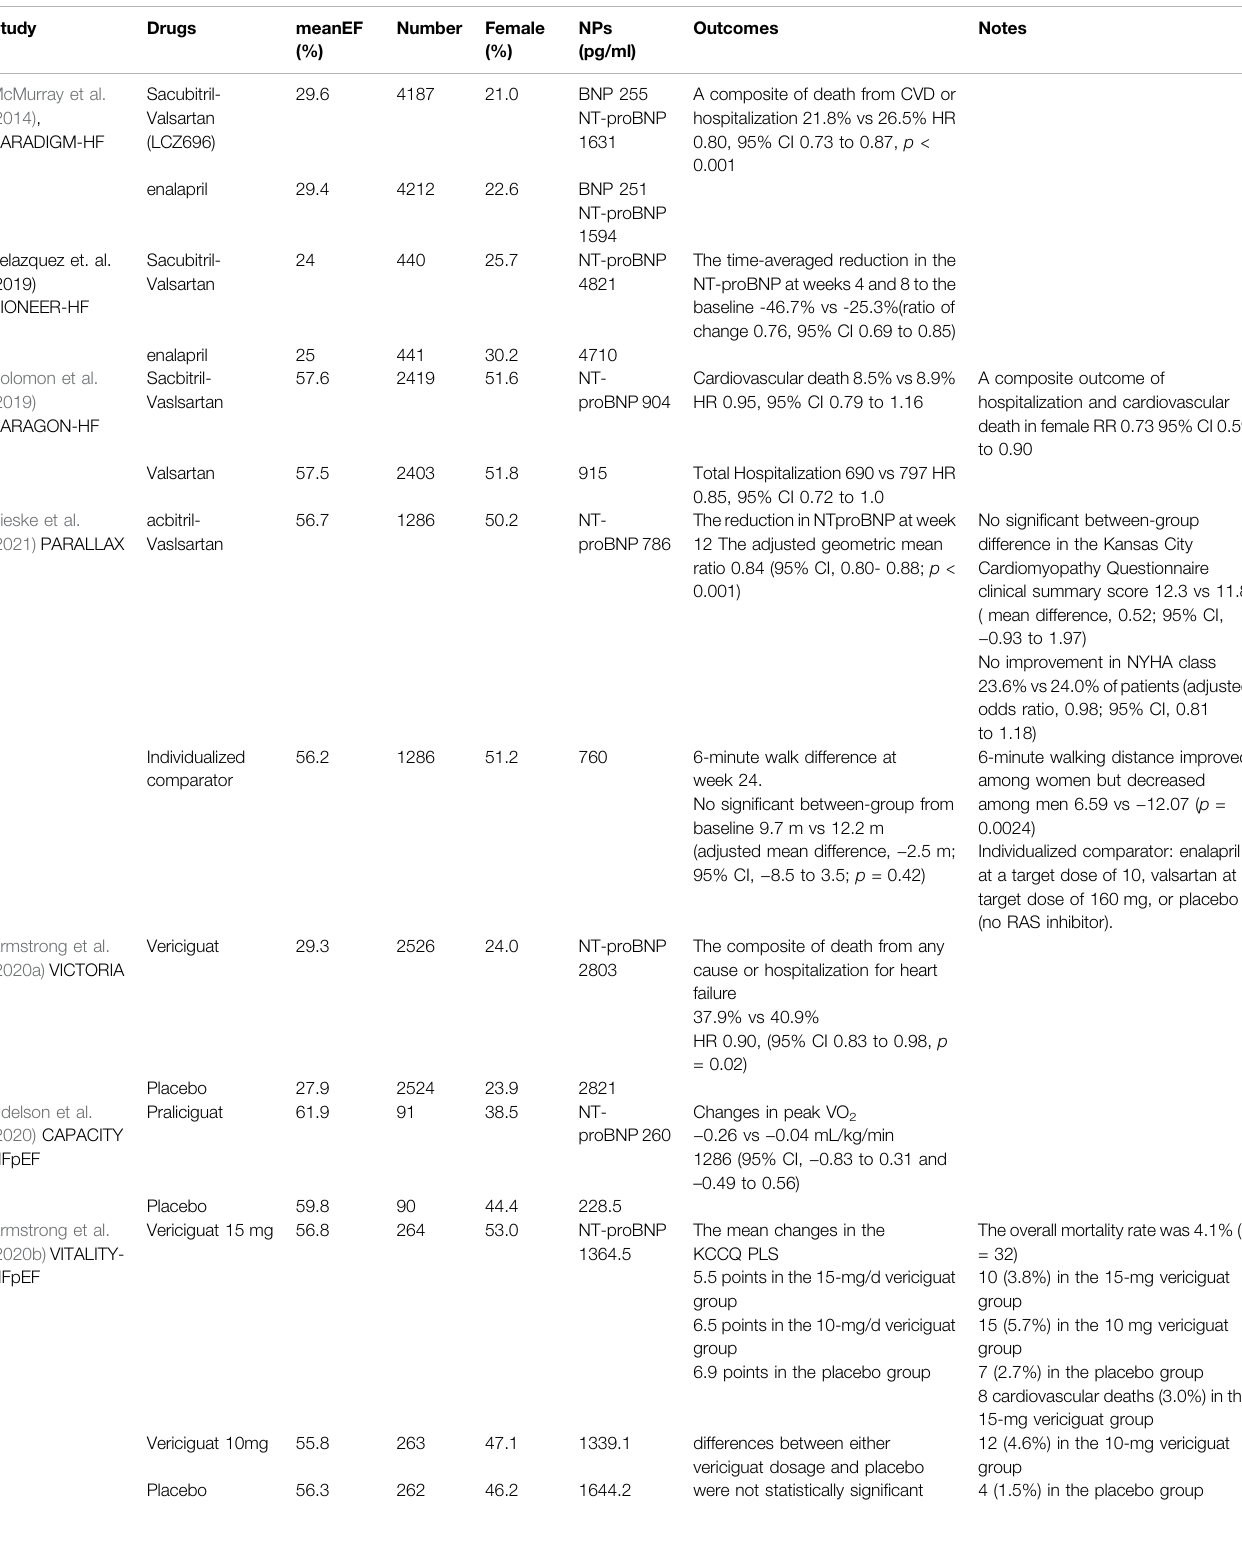
TABLE 1 | Clinical trials associated with sGC inhibitors and neprilysin